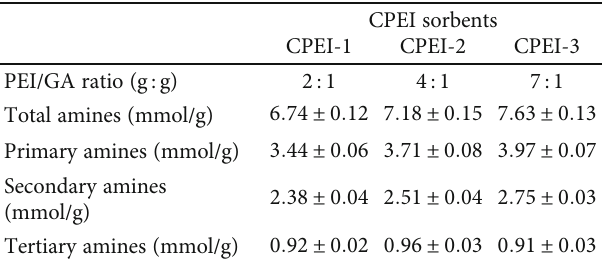
Table 1: In fl uences of various PEI/GA ratios used for the synthesis of CPEI on the total amine, primary amine, secondary amine, and tertiary amine values of